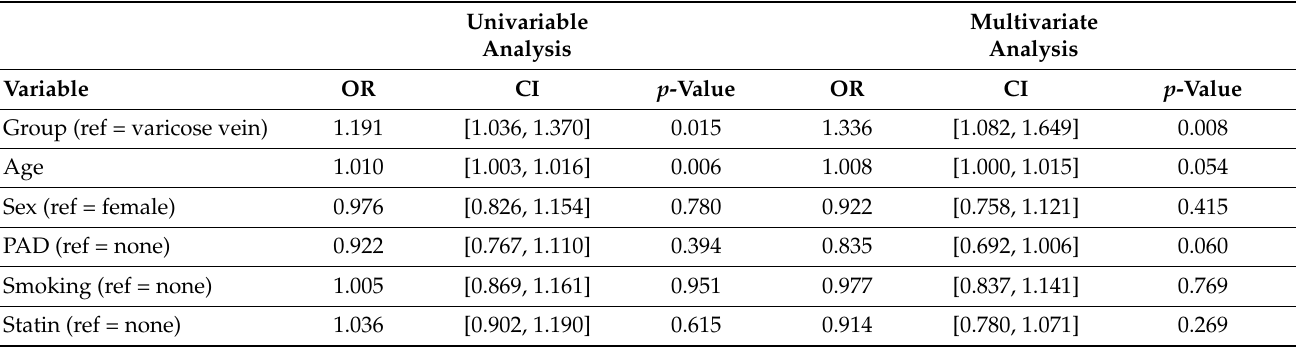
Table 3. Plasma sCD163 concentrations and associations with AAA disease, age, sex, PAD and prescription of statins.